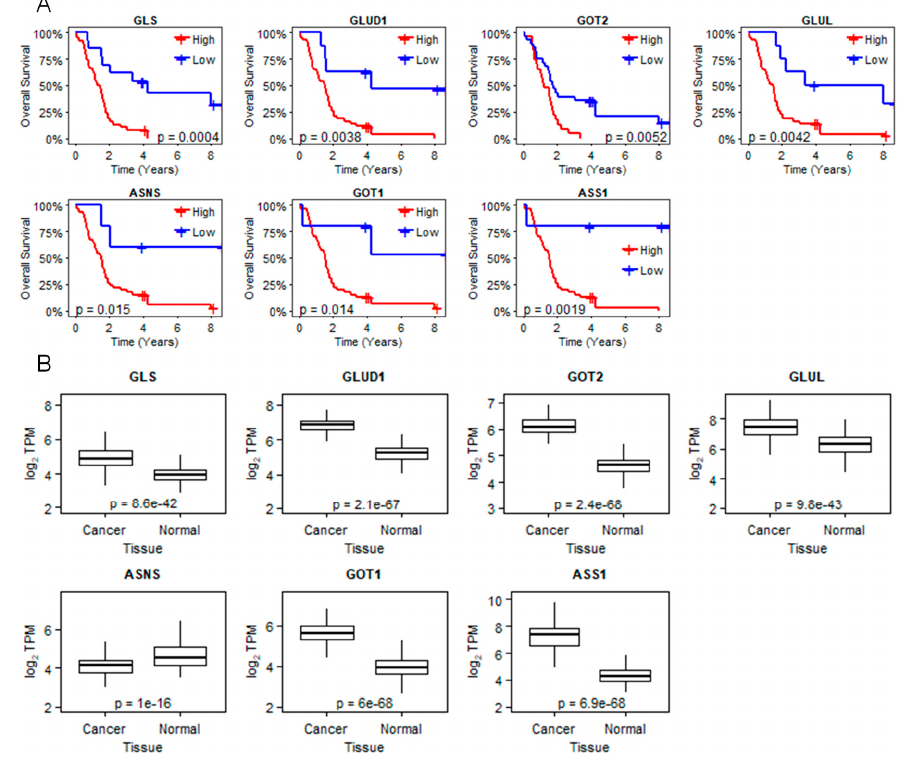
Figure 3. Key glutamine metabolism genes are differentially expressed in PDAC. ( A ) Kaplan–Meier survival plots of patients from the Kirby et al. dataset ( n = 51). Patients are grouped by high or low expression of glutamine metabolism genes in PDAC patients and their overall survival probabilities over time are displayed. p -values from the log-rank tests for survival di ff erences between high and low expression patient groups are reported. ( B ) Comparative gene analysis of pancreatic cancer samples ( n = 270) and normal tissue. Log2 transformed TPM values of key genes involved in glutamine metabolism. Results were obtained from the GTEx